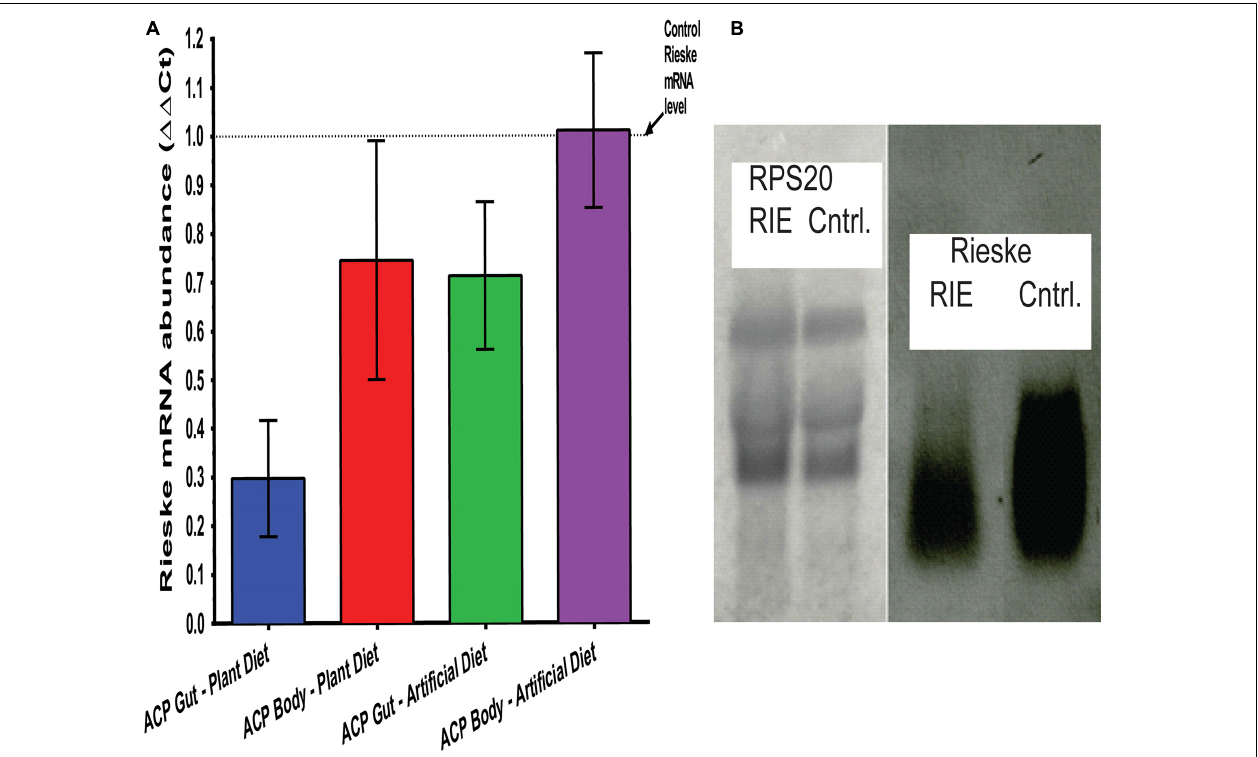
FIGURE 4 | Transcriptional modification of RIE in D. citri . (A) mRNA- RIE abundance ( (cid:49)(cid:49) Ct) after feeding D. citri on CTV- RIE infected citrus leaf or artificial diet containing dsRNA- RI E analyzed by qRT-PCR of gut and body extracts. (B) Northern blot analyses of control C. macrophylla leaf infected with CTV- RIE and CTV-wt (control), respectively, probed with RPS20 ribosomal proteins probe (left two lanes) and RIE probe (right two